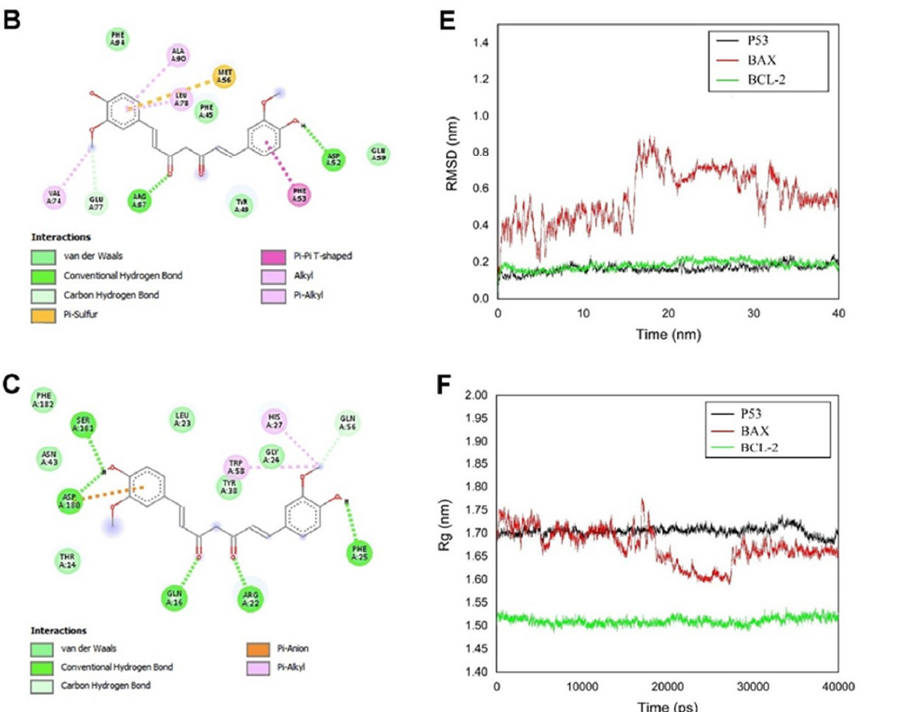
Figure 1. Interaction of ligands and target receptors. ( A ) Curcumin-Bax, ( B ) Curcumin-Bcl2, ( C ) Curcumin-p53; ( D ) Numbers of intermolecular hydrogen bonds in curcumin complex with p53 (black), Bax (red), and Bcl2 (green); ( E ) RMSD plot of curcumin complex with p53 (black), Bax (red), and Bcl2 (green); ( F ) The radius of gyration for p53 (black), Bax (red), and Bcl2 (green) in the presence of curcumin.